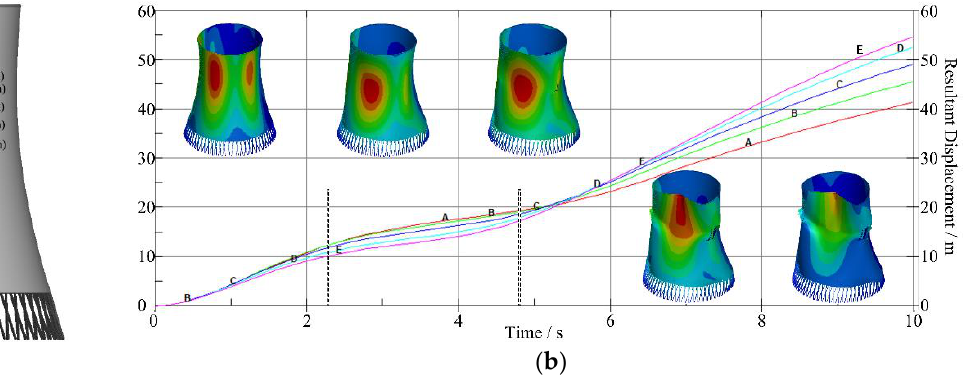
Figure 20. Time history of typical maximum displacement response nodes during the collapse process. ( a ) Response measurement point. ( b ) Displacement time history curve.